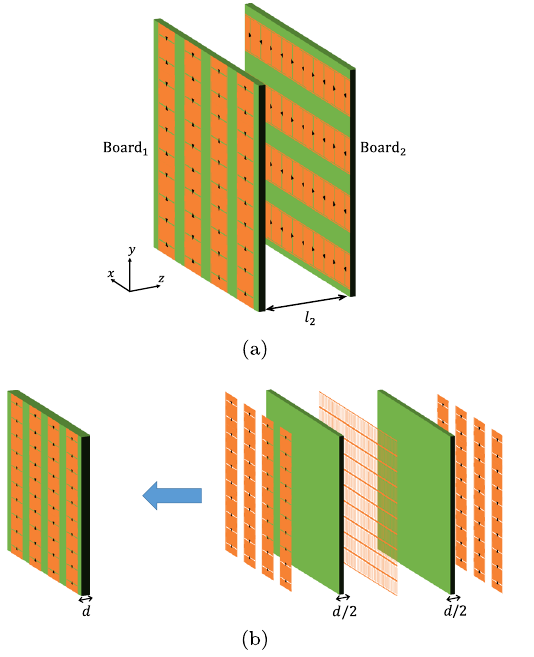
FIG. 4. (a) Topology of the BFS consisting of two birefringent boards rotated 90° with respect to each other ( l 2 ¼ 3 . 26 mm). (b) Each birefringent board consists of three patterned metal sheets. The sheets are cascaded with substrates of overall thick- ness of d ¼ 3 . 15 mm.